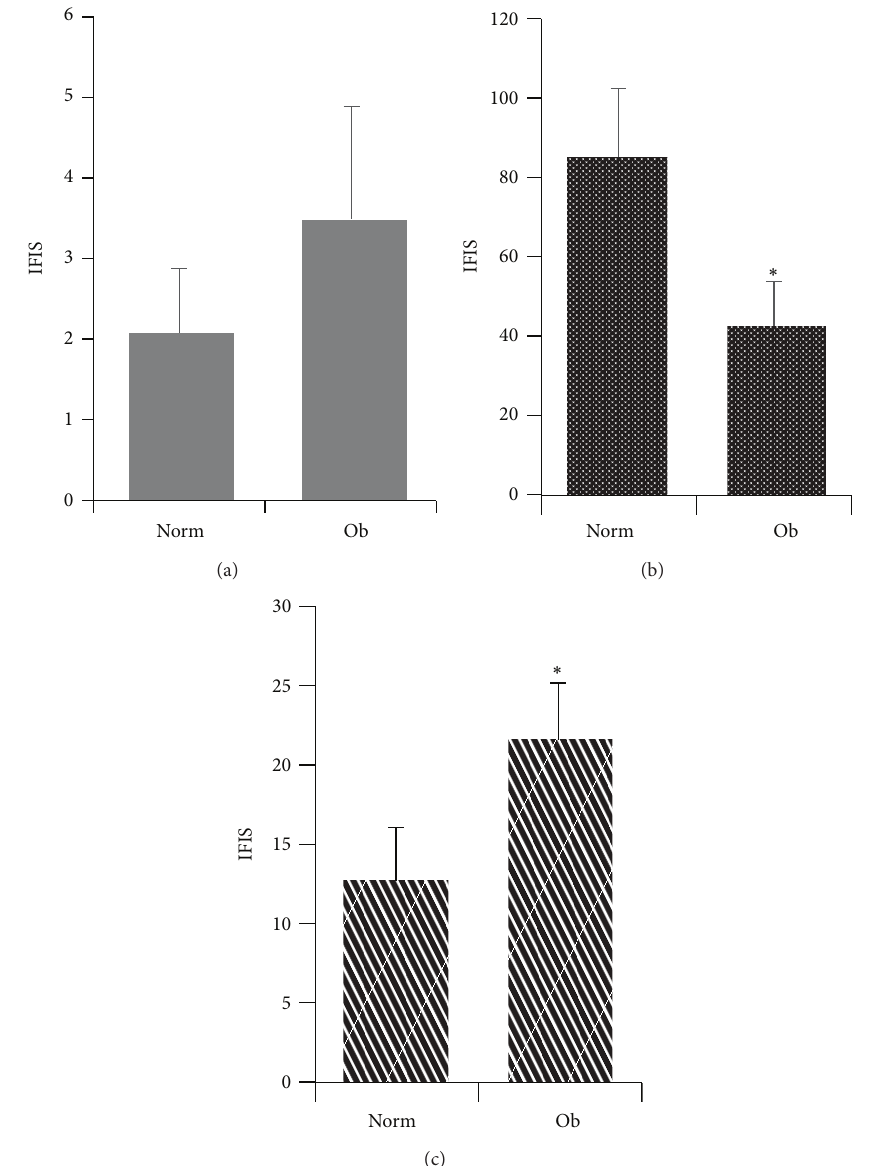
Figure 3: CD2, CD56, and PLZF fluorescence levels in normal colorectal mucosa of subjects with normal colonoscopy. Fluorescence levels of CD2 (a), CD56 (b), and PLZF (c) immunostaining in normal colorectal mucosa of subjects with normal weight (Norm: BMI < 25 Kg/m 2 and waist circumference < 88 cm for women and < 102cm for men) and obese subjects (Ob: BMI ≥ 25 Kg/m 2 and waist circumference ≥ 88 cm for women and ≥ 102 cm for men) expressed by immunofluorescence intensity score (IFIS). ∗ 𝑃 < 0.05 versus